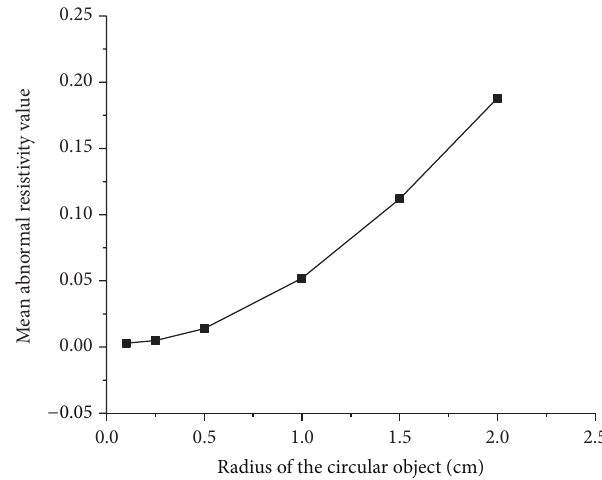
Figure 15: MARV of ROI in the SEIT reconstructions of the simulated hemorrhagic stroke lesions of different sizes: 2.00, 1.50, 1.00, 0.50, 0.25, and 0.10